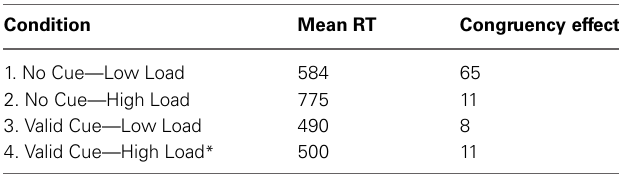
Table 1 | Mean RTs (average of congruent, neutral and incongruent trials) and congruency effects (incongruent RT—congruent RT) for each condition in Johnson et al.’s (2002)